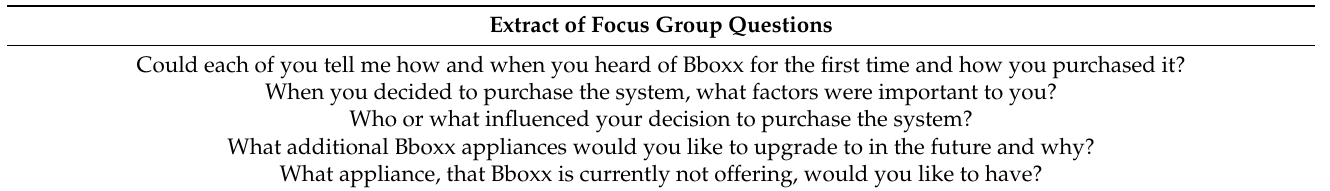
Table A2. Extract of focus group questions. Extract of Focus Group